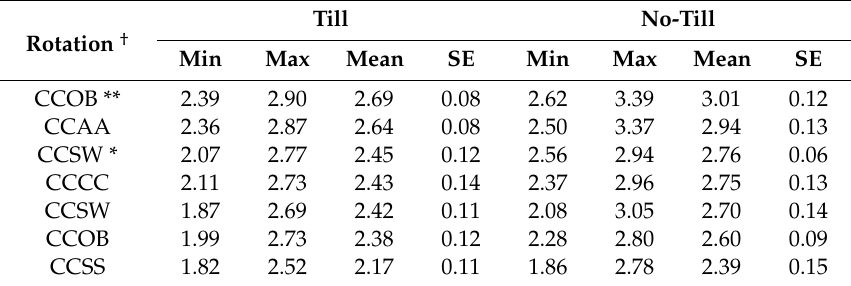
* : Rotation with the same crops in different phases in Table 1 that are not significantly different